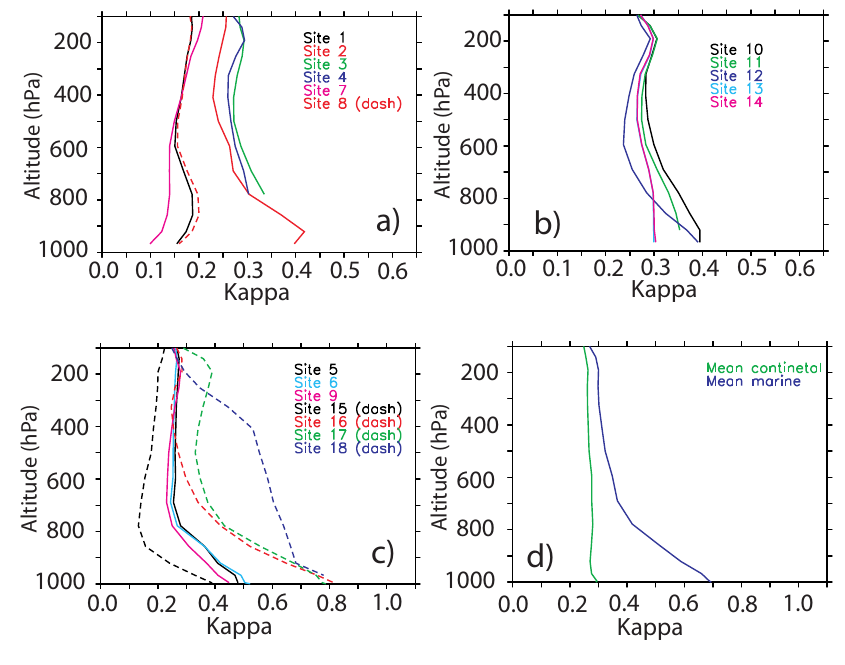
Fig. 3. Vertical distribution of κ at the sites shown in Fig. 4. Plots (a) and (b) show continental sites plot (c) shows continental sites with strong marine influence (solid line) and marine sites (dash) and plot (d) shows the vertical profile of the global mean of all continental and all marine regions. Note x-axis changes between plots.